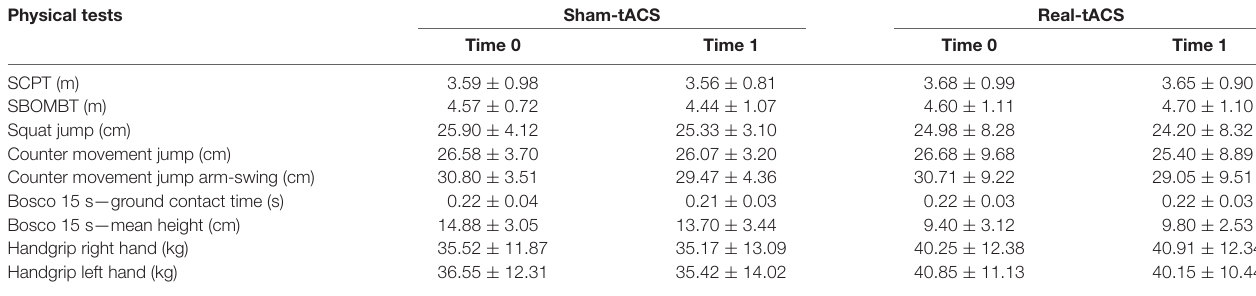
TABLE 2 | The mean values and standard deviation at times 0 and 1 for real and sham-tACS group, for each physical test. Physical